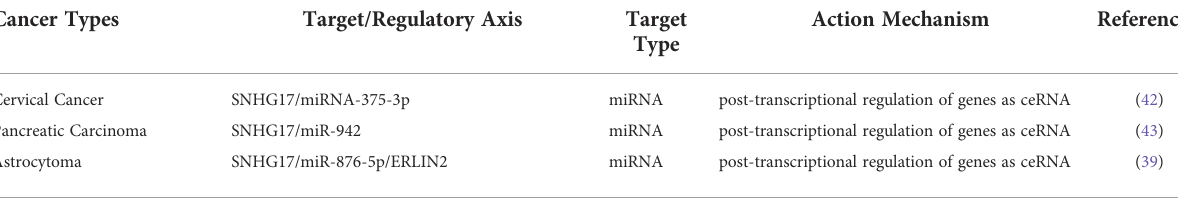
TABLE 2 The targets and mechanisms underlying the effects of